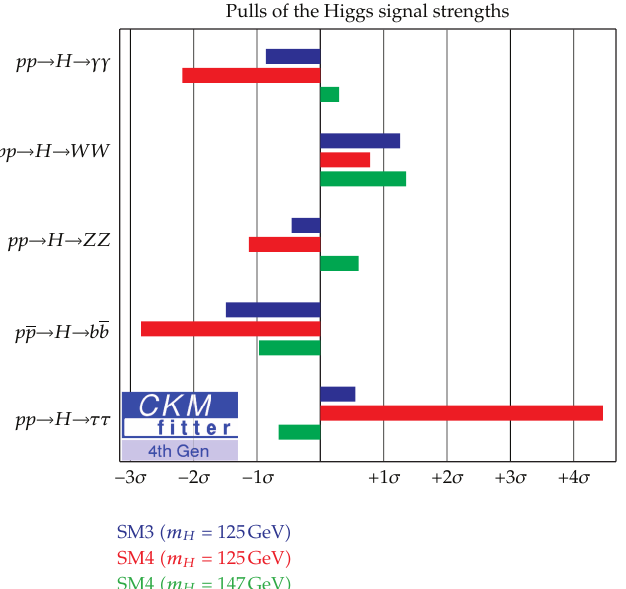
Figure 8: Pulls of the Higgs signal strengths with the data before ICHEP 2012. Figure from [18].